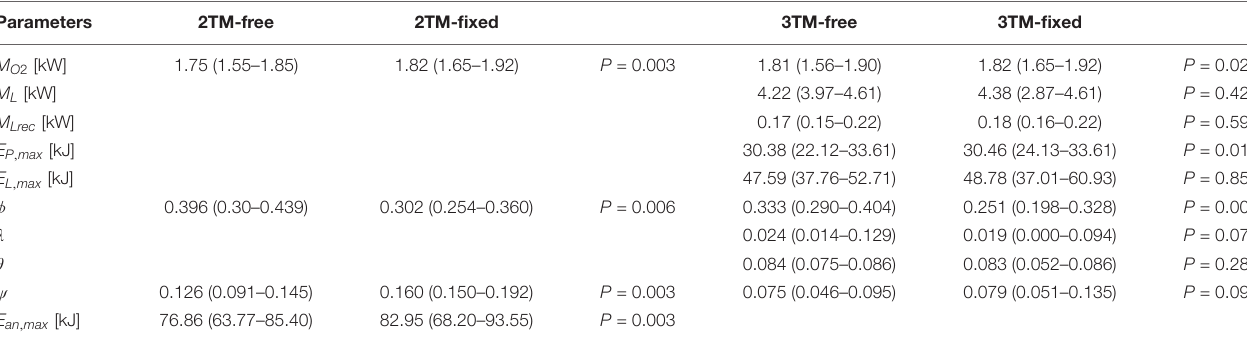
TABLE 3 | The median and interquartile range (IQR) of estimated optimal parameters for the four bioenergetic models.